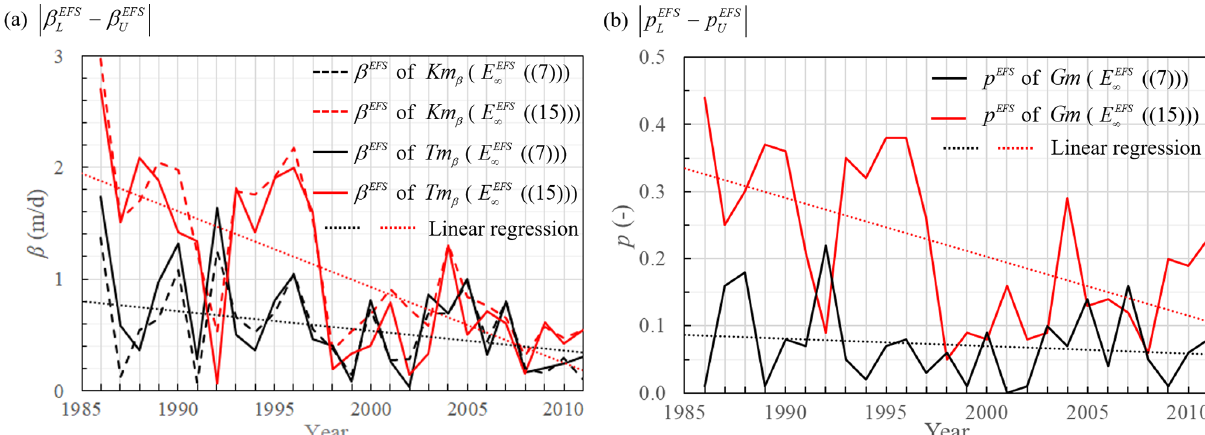
(cid:12) (cid:12) (cid:12) (cid:12) − β EFS β EFS (cid:12) (cid:12) and (b) L U